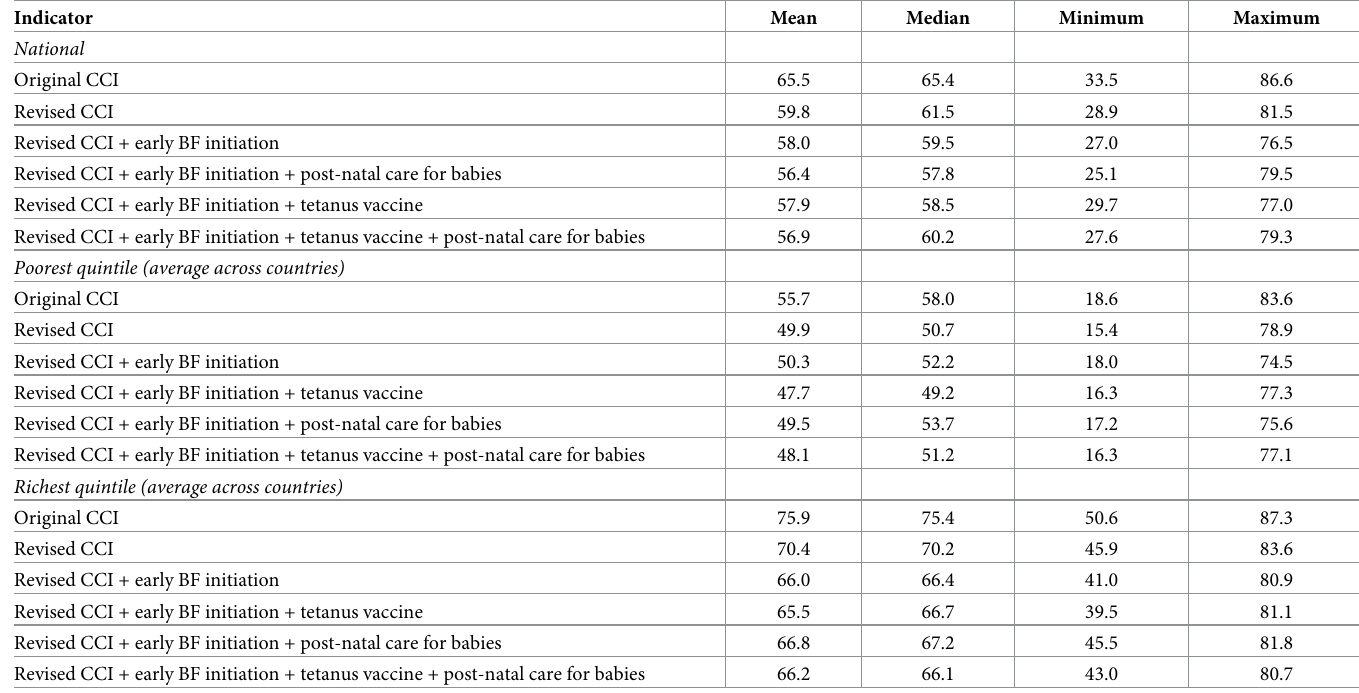
Table 2. Summary statistics for different formulations of the CCI in 47 countries.